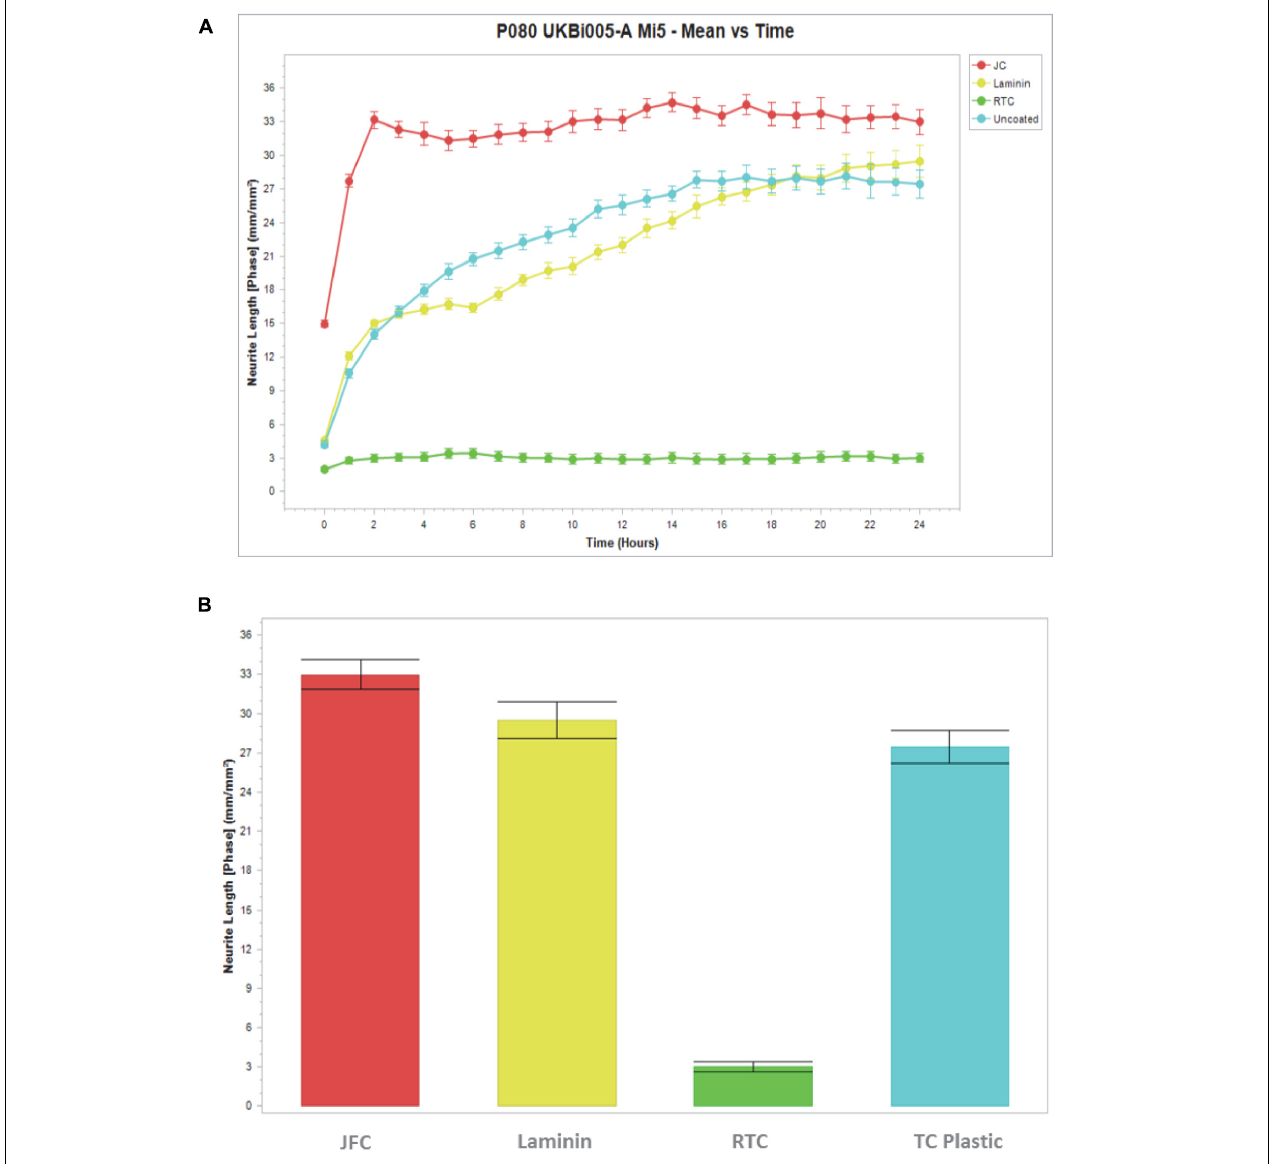
FIGURE 5 | Measure of cell ramification using neurite length software on the Incucyte. Cells were cultured in Jellagen (JFC: 10 µ g/mL), Rat tail collagen (RTC 10 µ g/mL), laminin or plastic (uncoated) and (A) imaged every hour for 24 h with neurite length quantified. (B) Neurite length quantification after 24 h in culture. Data represent mean ±